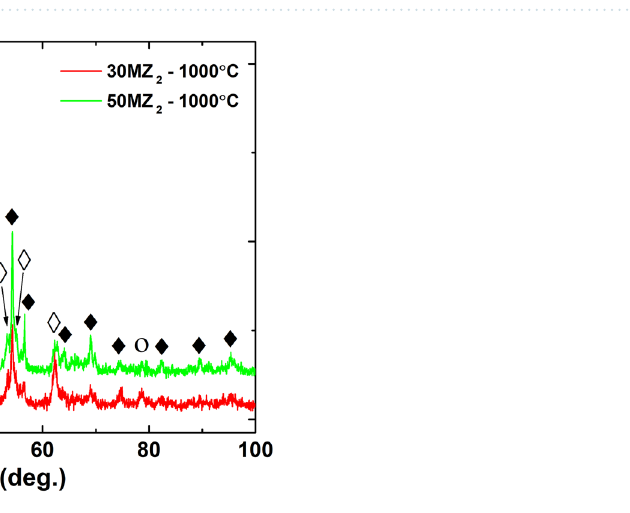
Figure 5. XRD patterns of 30MZ 2 and 50MZ 2 thermal treated at 1000 °C in nitrogen atmosphere; where (cid:31) -